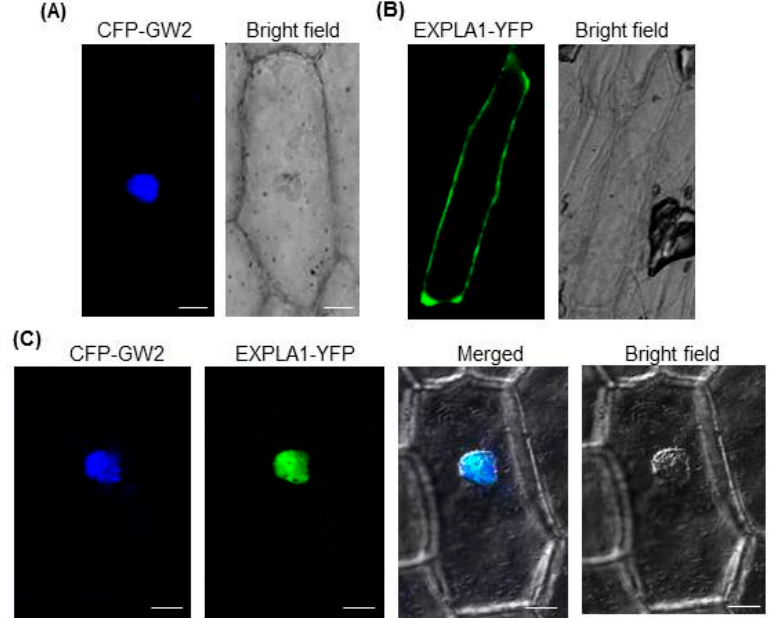
Figure 3. GW2 and EXPLA1 colocalize in the nucleus. CFP–GW2 and EXPLA1–YFP were transiently